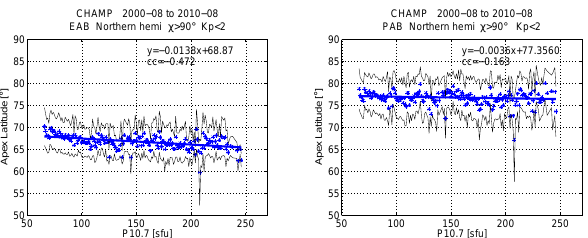
Figure 9. The dependence of the auroral boundary latitude on the Fig. 9. The dependence of the auroral boundary latitude on the solar flux index P10.7. For the equatorward solar flux index P 10 . 7. For the equatorward boundary (left) all local boundary (left) all local times from 0000 to 2400 MLT are considered, while for the poleward boundary (right) times from 00:00 to 24:00MLT are considered, while for the pole- only detections from the time sector 0800 to 1600 MLT have been used. The blue asterisks are the mean values ward boundary (right) only detections from the time sector 08:00 to of activity bins and the black lines denote the standard deviation of the bin values. 16:00MLT have been used. The blue asterisks are the mean values of activity bins, and the black lines denote the standard deviation of the bin values.